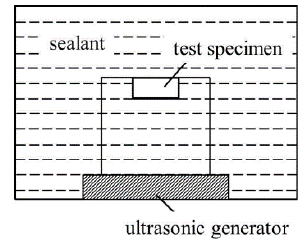
Figure 1. Schematic diagram of ultrasonic excitation sealing apparatus.